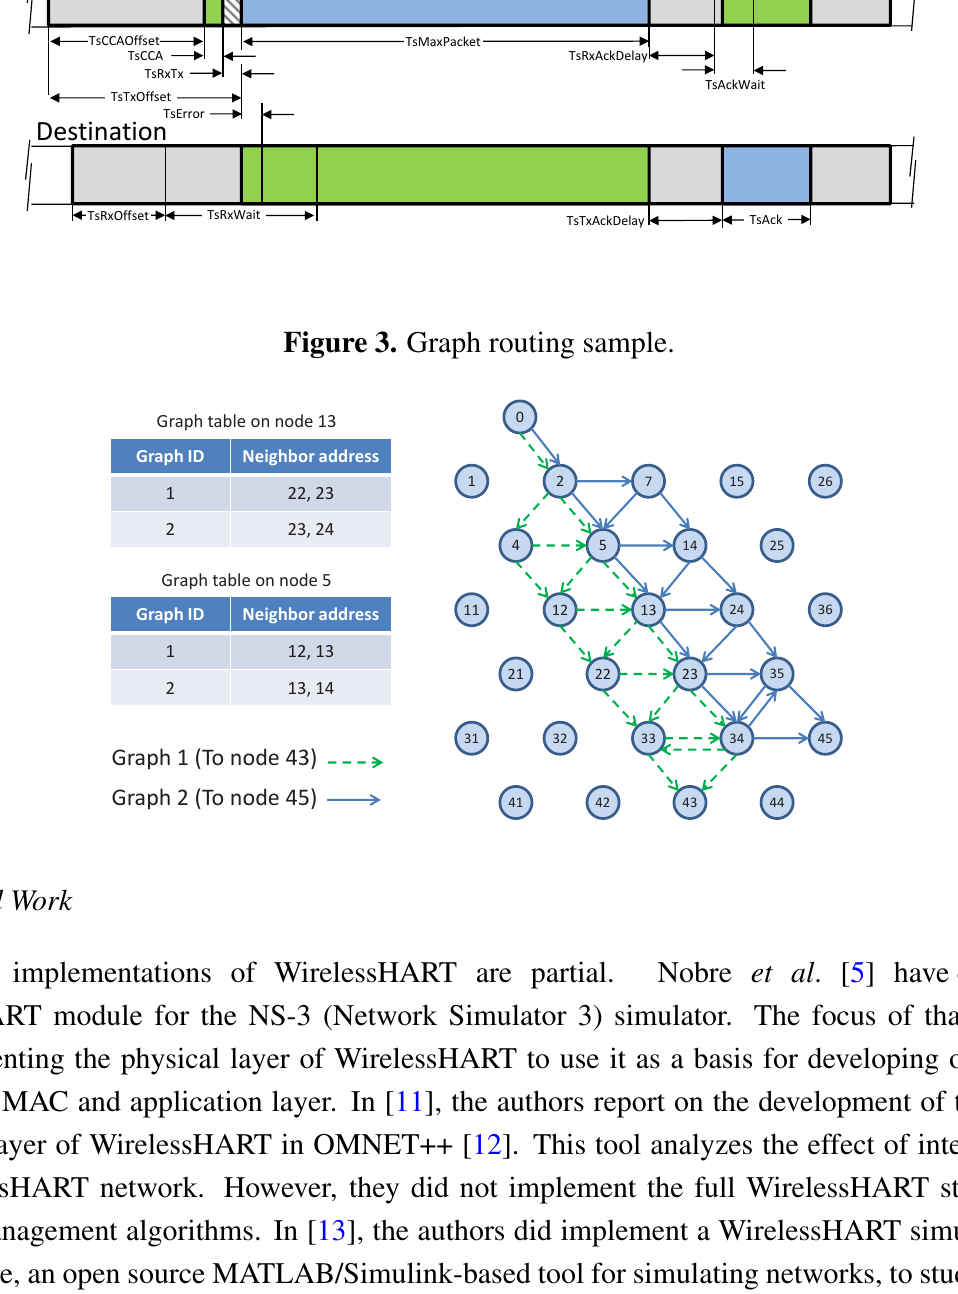
Figure 1. TSCH Slot-channel matrix (right) for the network shown on the left.